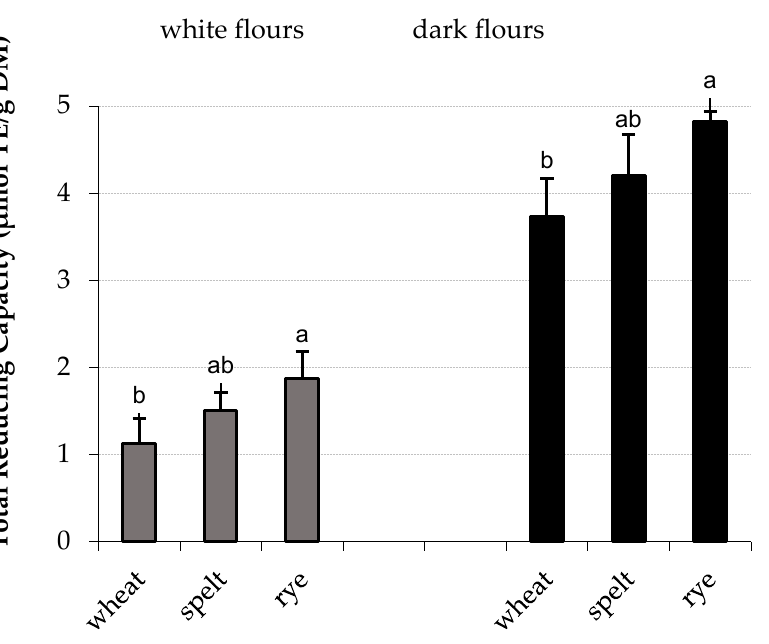
Figure 3. The total reducing capacity of white and dark flours originated from wheat, spelt, and rye. Data are the mean of three independent replicates ± SD. Similar letter as superscripts for bars related to the white or dark flours indicates no significant differences ( p ≤ 0.05).